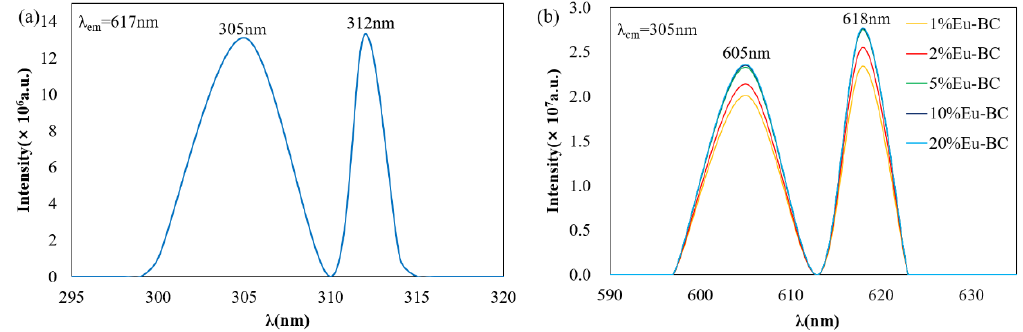
Figure 4. ( a ) Fluorescence excitation spectra of Eu-BC and ( b ) fluorescence emission spectra of fluorescent paper sheets with different Eu-BC contents.